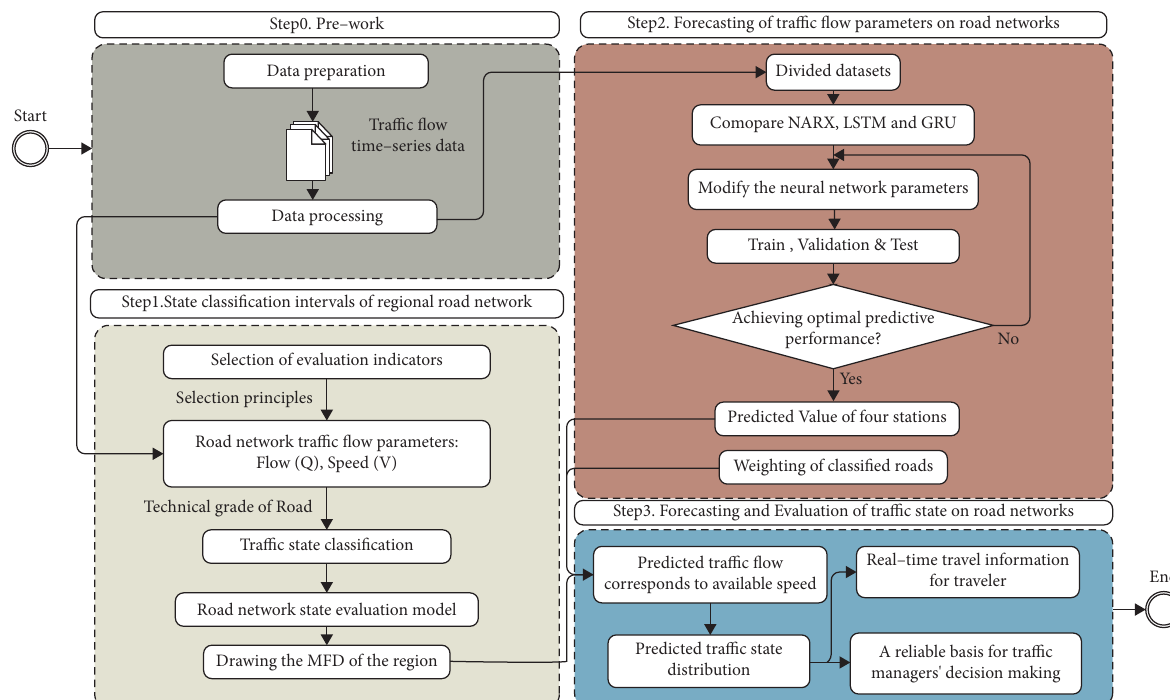
Figure 4: Flowchart of road network’s traffic state prediction.